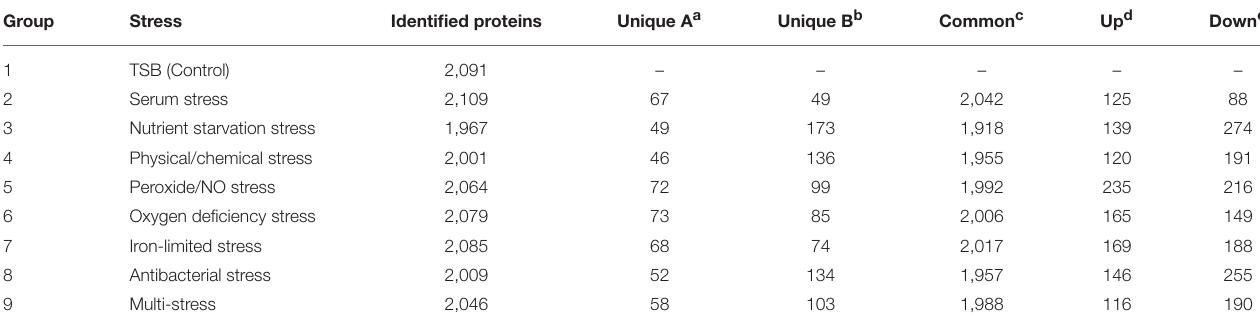
TABLE 2 | Overview of B. abortus proteins identified under environmental stress.